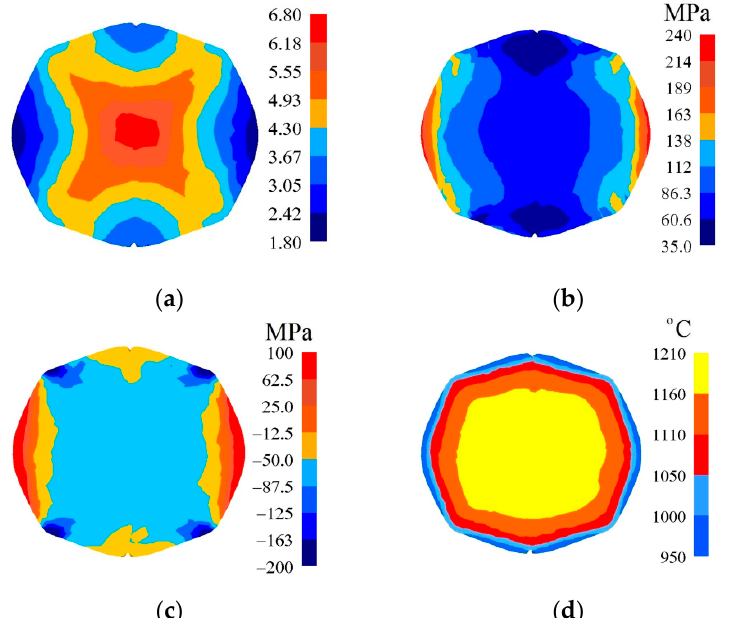
Figure 16. Distribution of the effective strain ( a ), effective stress ( b ), mean stresses ( c ), and temperature ( d ) after the fourth pass of the forging with a concave cross-section in V-shaped anvils ( α c = 165°, ε c = 0.51, forging ratio 4.2).